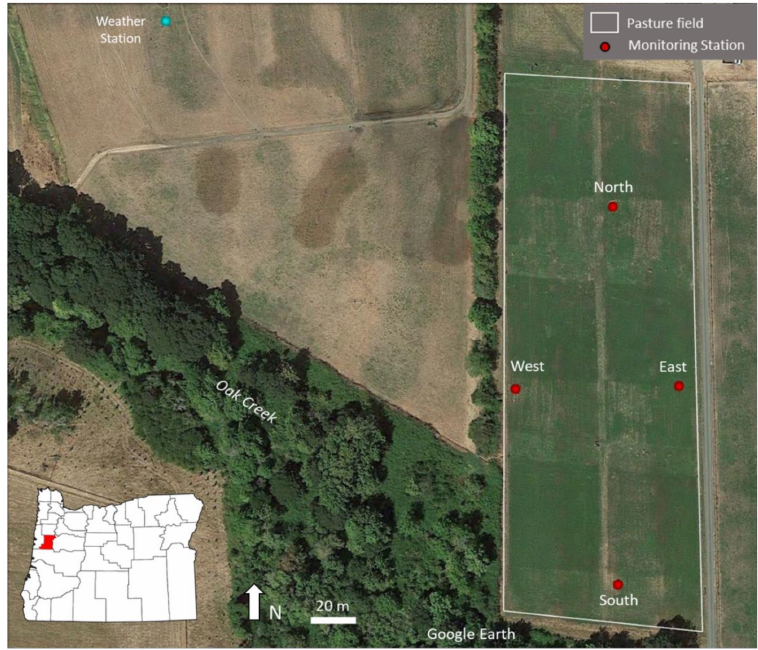
Figure 1. Study site illustrating the location of the four monitoring stations used to measure soil water content and groundwater levels. Study site (44.568 Lat.; − 123.301 Long.) is in Benton County, Oregon,